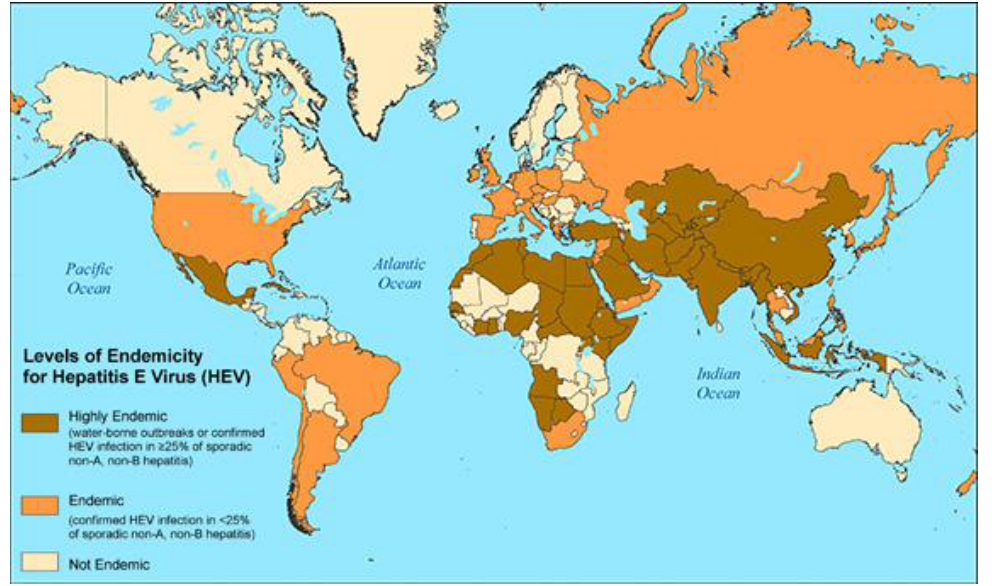
Figure 6. Hepatitis E viral genome [76]. This image was used with permission from the publisher.